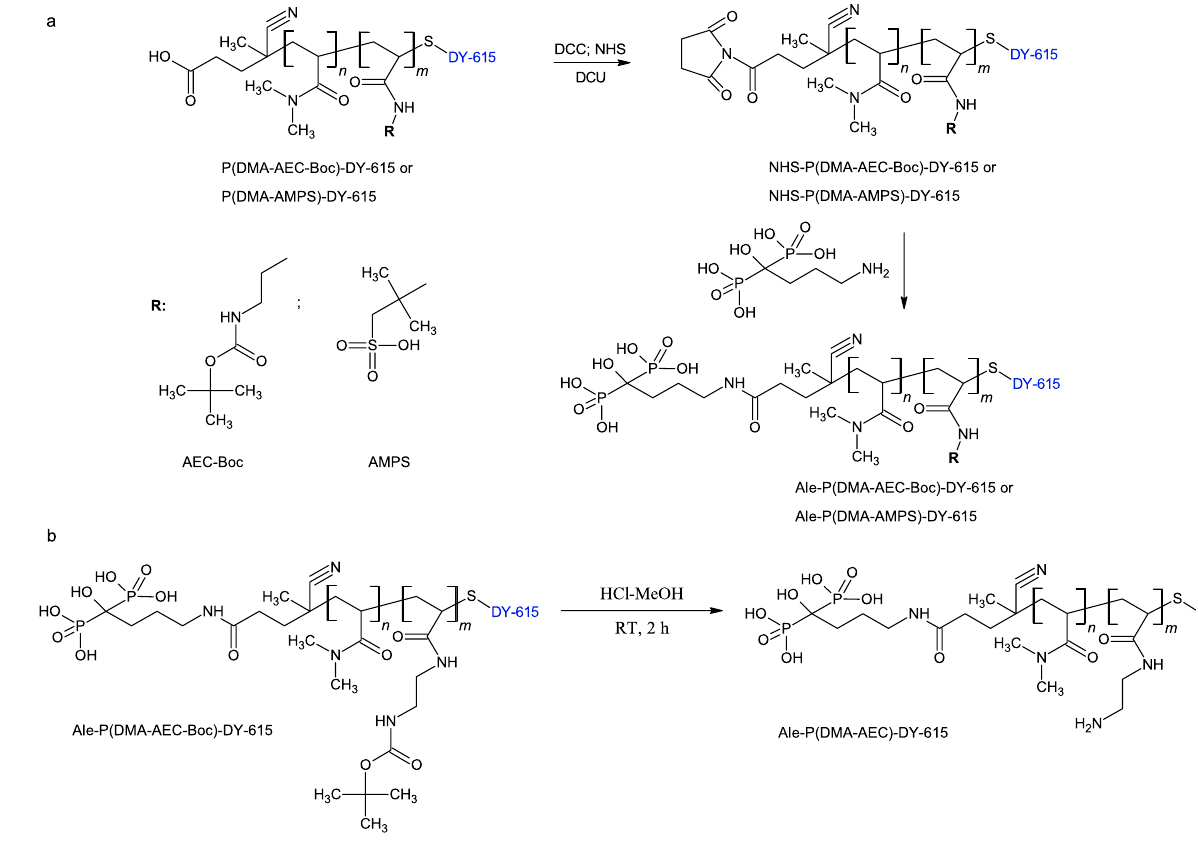
Figure 3. ( a ) Activation of carboxyl-end groups of P(DMA-AEC-Boc)-DY-615 or P(DMA-AMPS)-DY-615 with N -hydroxysuccinimide (NHS) and N , N ′ -dicyclohexylcarbodiimide (DCC) and reaction with alendronate (Ale). ( b ) N -Boc deprotection of Ale-P(DMA-AEC-Boc)-DY-615.